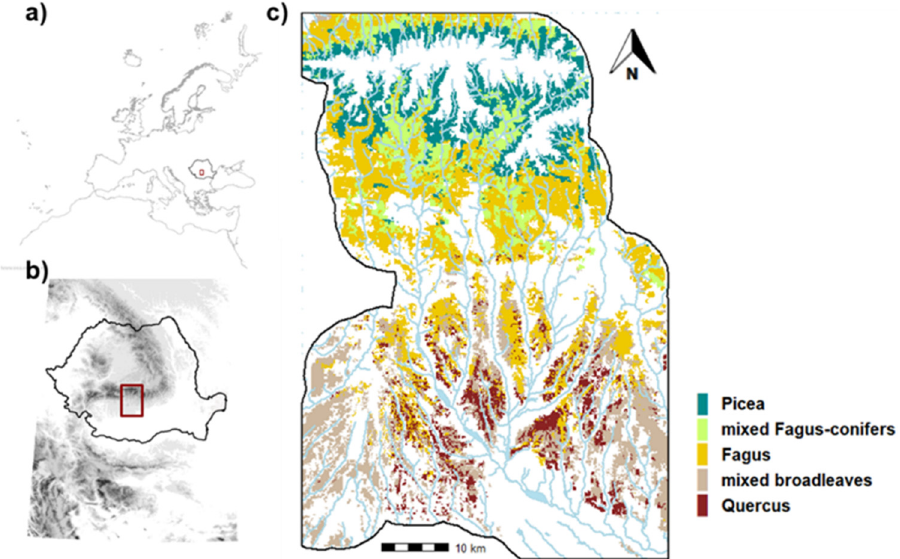
Figure 1. ( a ) Location of the study area within Europe and ( b ) the Carpathians; ( c ) distribution of the five forest types within the study area.